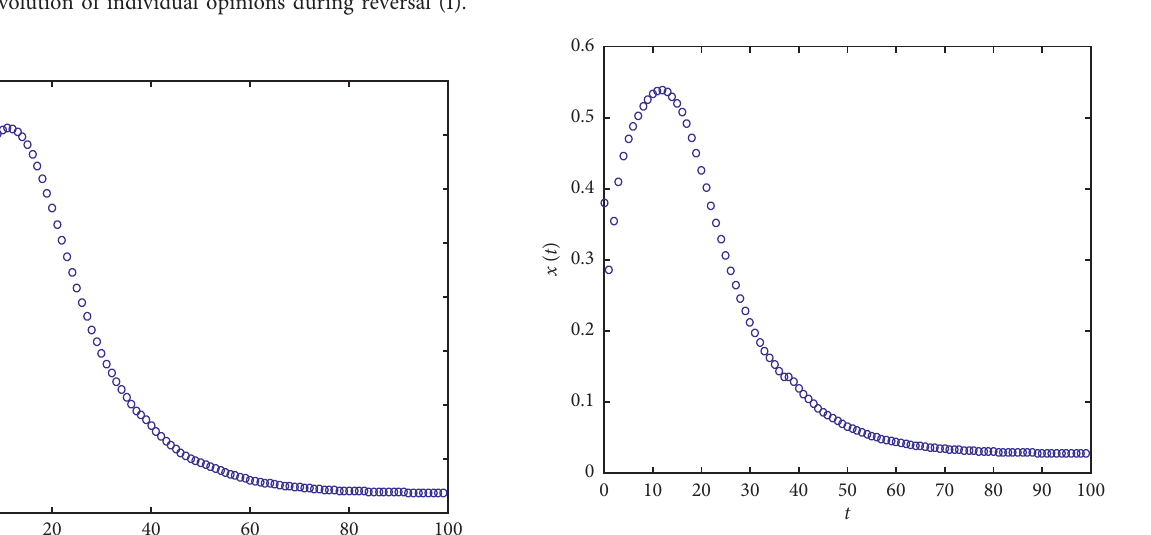
Figure 5: Evolution of average collective opinions (II).